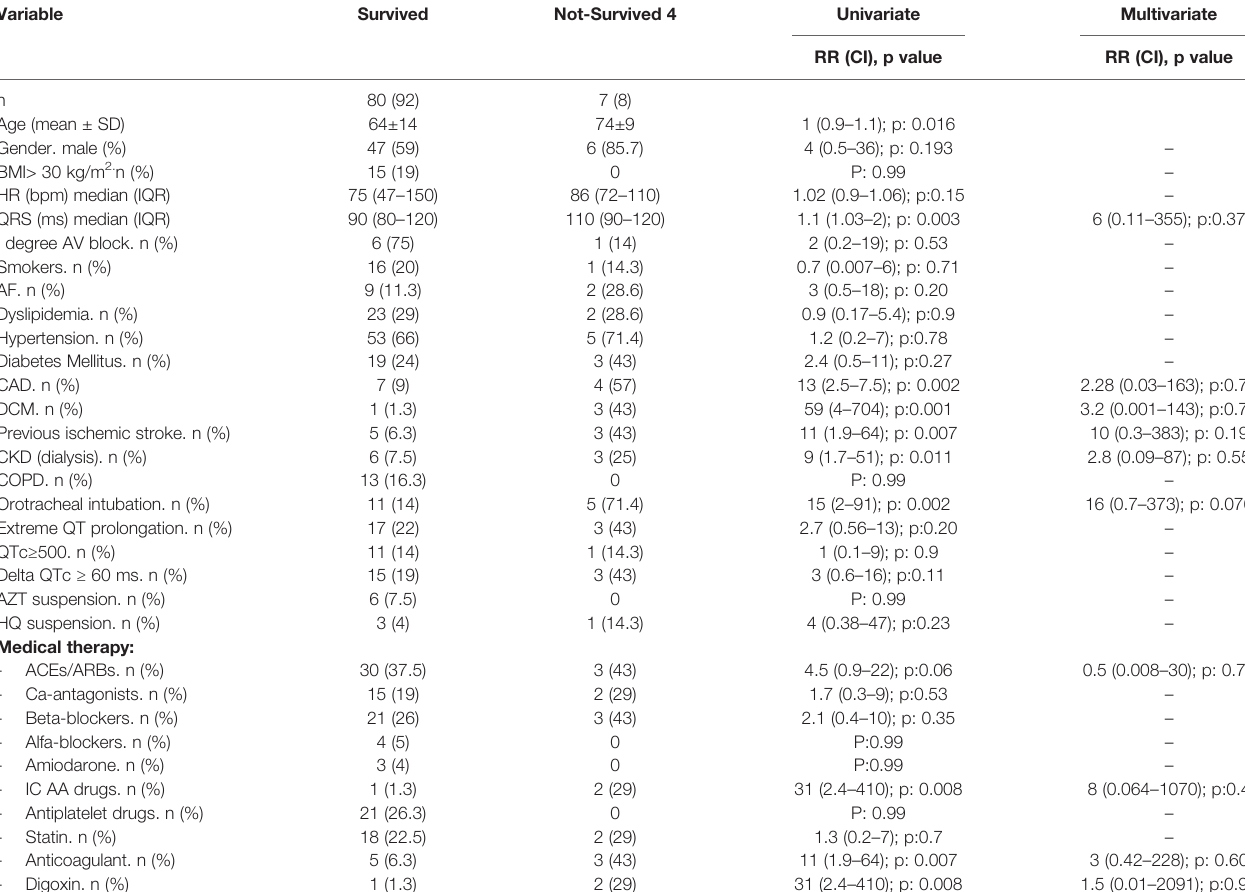
TABLE 3 | Distribution of patients ’ characteristics and their association with death occurrence among COVID-19 study